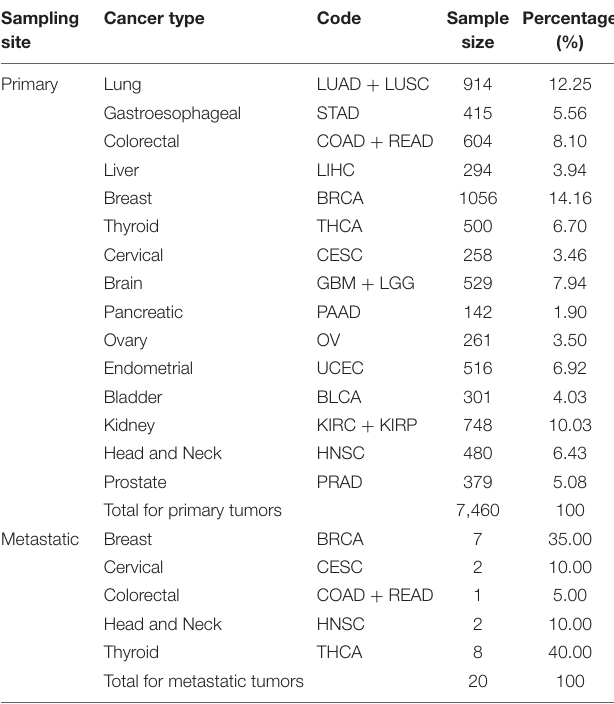
TABLE 1 | Summary of samples used in the